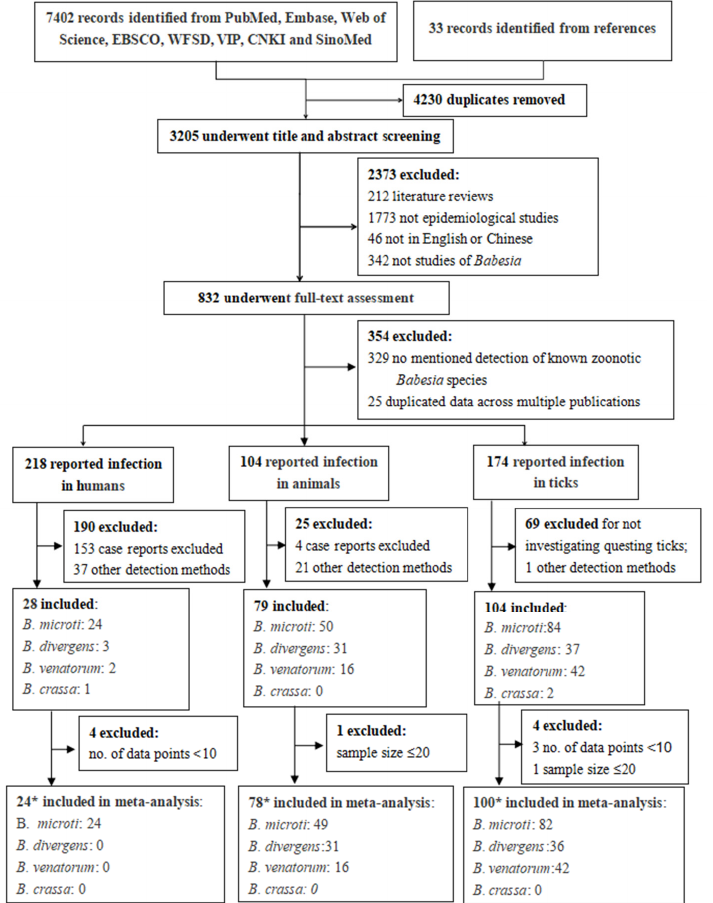
Figure 1. Flow diagram of study selection. * In the included studies, a total of 18 studies reported dual infection of humans, animals or ticks, of which four studies reported the infection of human and ticks [31–34], and 14 studies reported the infection of ticks and animals [35–48]. In addition, some studies reported more than one zoonotic Babesia